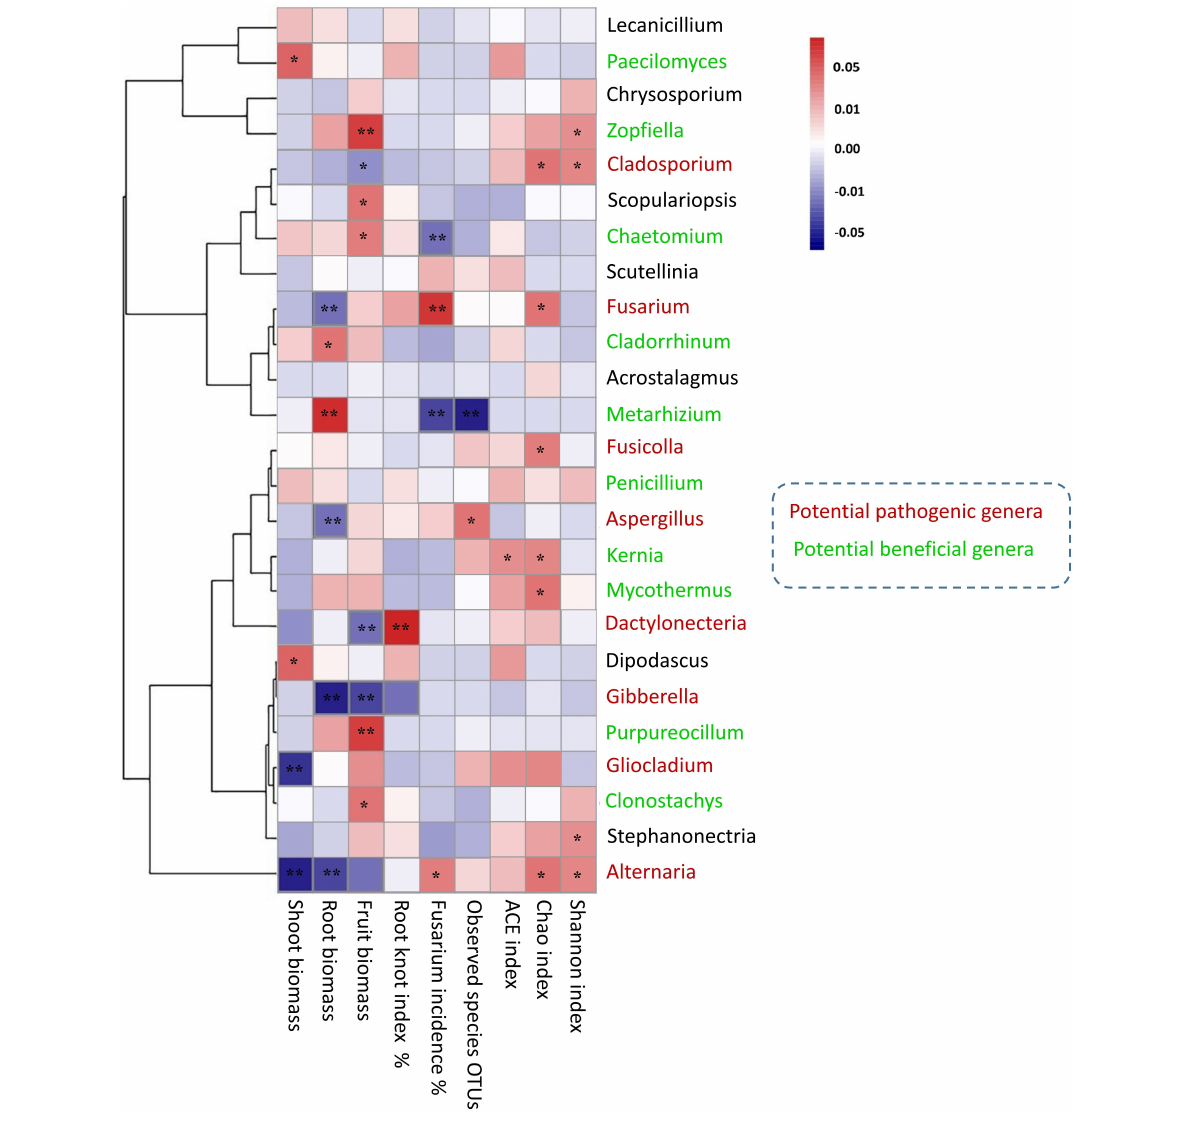
FIGURE 7 | Heat map analysis illuminates the relationship between potential microbial taxa (beneficial and pathogenic) and plant growth characters and disease incidence. Correspondent Spearman’s rank correlation coefficient for each taxon suggests the degree of the positive and negative association at *0.05; **0.01 significance